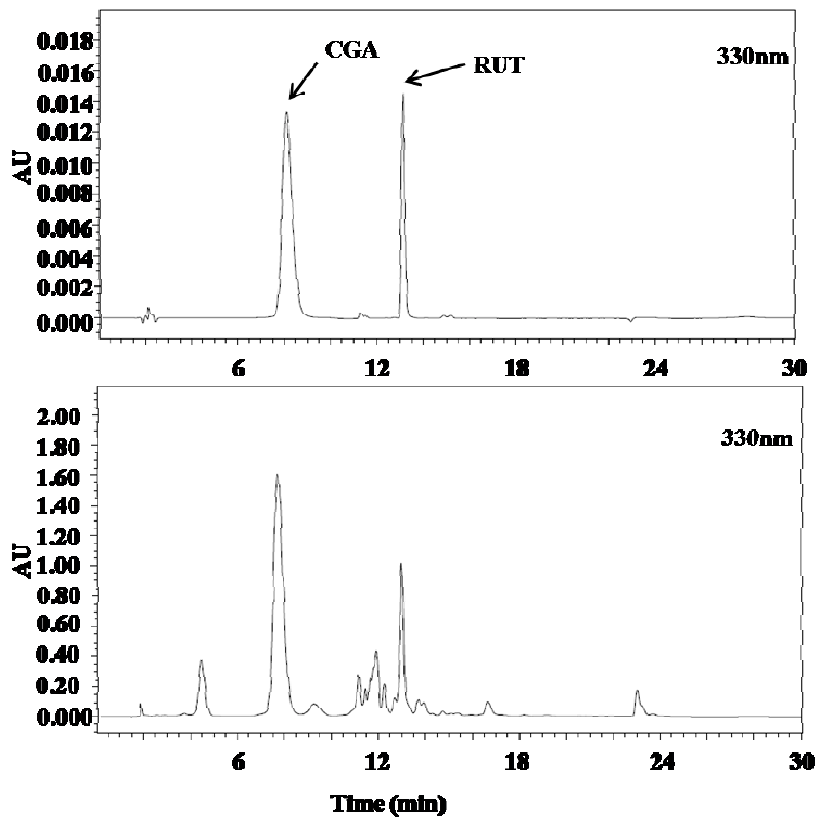
Figure 1. Chromatogram of standard and D. morbifera leaf extract.